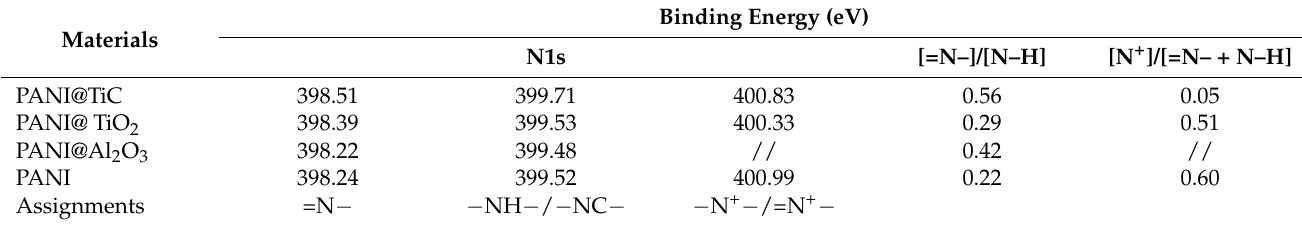
Figure 2. XPS spectra in N 1 s region of ( a ) PANI@TiC, ( b ) PANI@TiO 2 , ( c ) PANI@Al 2 O 3 , and ( d ) PANI samples. Table 1. N 1 s data, intrinsic oxidation state, and doping degree of conducting materials from XPS